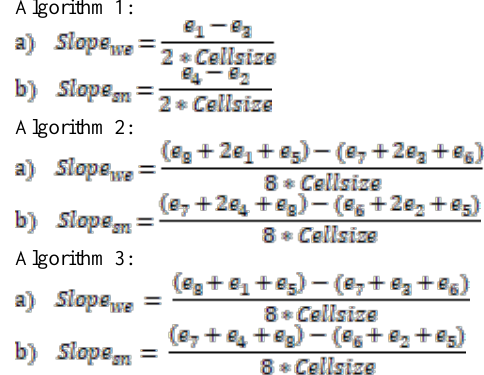
The calculation of